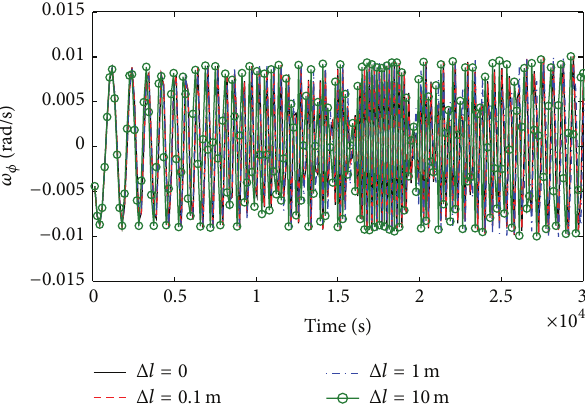
Figure 19: The time history of pitch angular acceleration error Δ𝛼 𝜓 with different Δ𝑙 , 𝜏 = 0 .